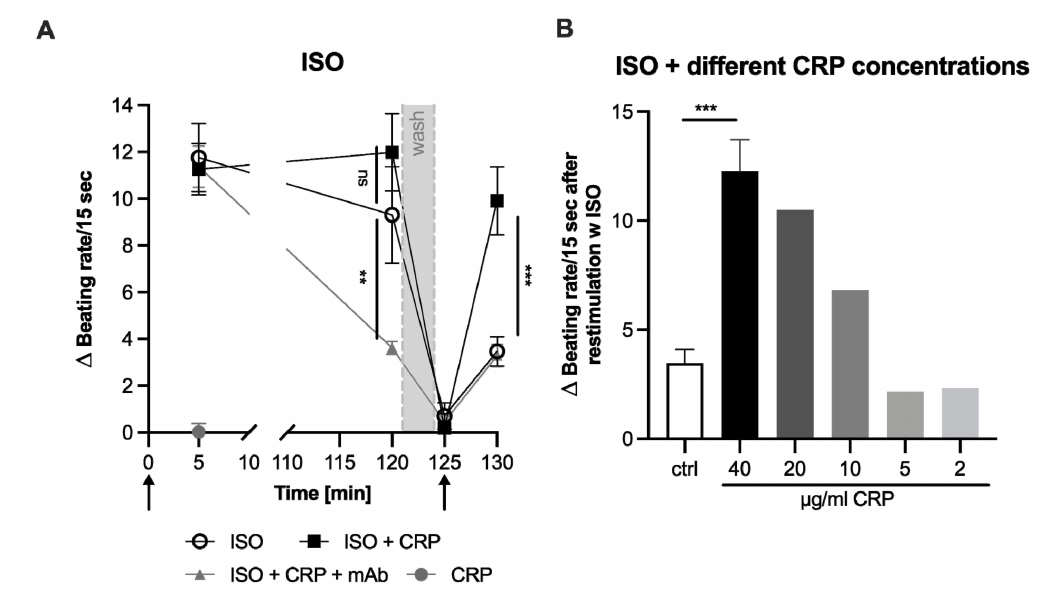
Figure 1. CRP blocks the desensitization of stimulated neonatal rat cardiomyocytes with ISO. Dif- ference of cardiomyocyte beating rates [ ∆ Beating rate/15 s] modulated by adrenoceptor agonist isoprenaline (ISO) with or without CRP co-incubation. ( A ) Mean of 3–7 independent experiments ± standard deviation is depicted. Arrows indicate stimulation with respective agonists. Grey area indicates washing step. After the washing step, the agonist was added again but no CRP. To test if CRP itself influences the beating rate, cells were incubated with CRP and no change could be observed after 5 min (grey circle). Significance of difference between CRP incubated and control group and mAb group at 120 min and 130 min was calculated with two-way ANOVA with Bonferroni post-hoc test. ( B ) Same experimental setup as depicted in ( A ), but only the beating rate at the last time point (130 min) is shown as mean of 3–5 independent experiments ± standard deviation or as single value (20–2 µ g/mL CRP). Significance of difference between 40 µ g/mL CRP and control (only ISO) was calculated with student’s t -test. ** p < 0.01. *** p < 0.001. ns: not